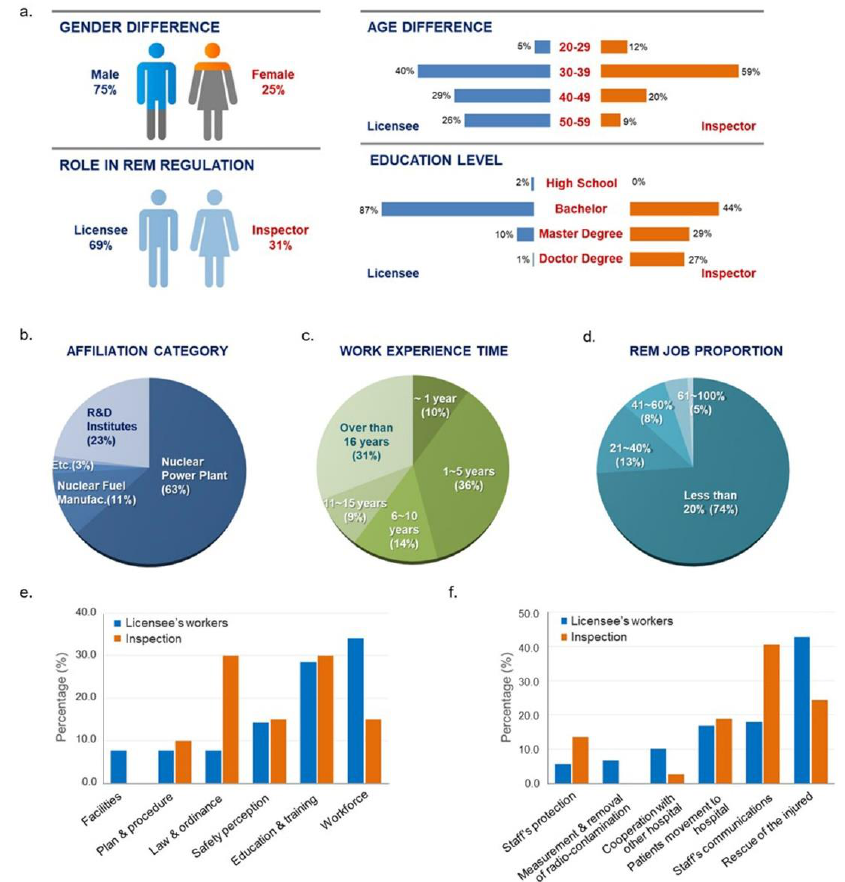
Figure 3. Important factors for safety regulation of radiation emergency medicine. ( a ) General characteristics of respondents, ( b ) Distribution of the affiliation types, ( c ) Distribution of career period ( d ) Job proportion in REM, ( e ) Important factors of REM safety regulation, ( f ) Important factors in the response of REM. REM: regulation of emergency.